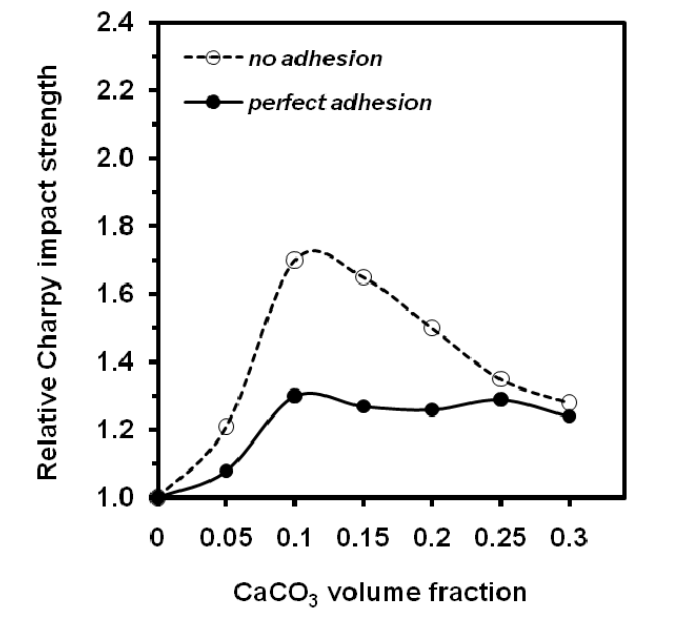
Figure 20. Influence of CaCO strength (adapted from